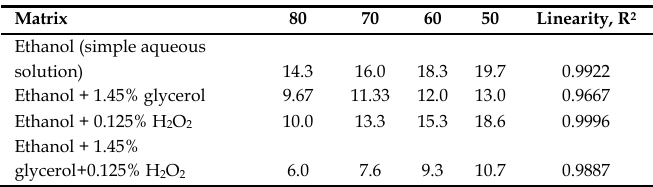
Comparison of the average number of drops of oxalic acid in different ethanol concentrations and different matrices Matrix 80 70 60 50 Linearity, R 2 Ethanol (simple aqueous solution) 14.3